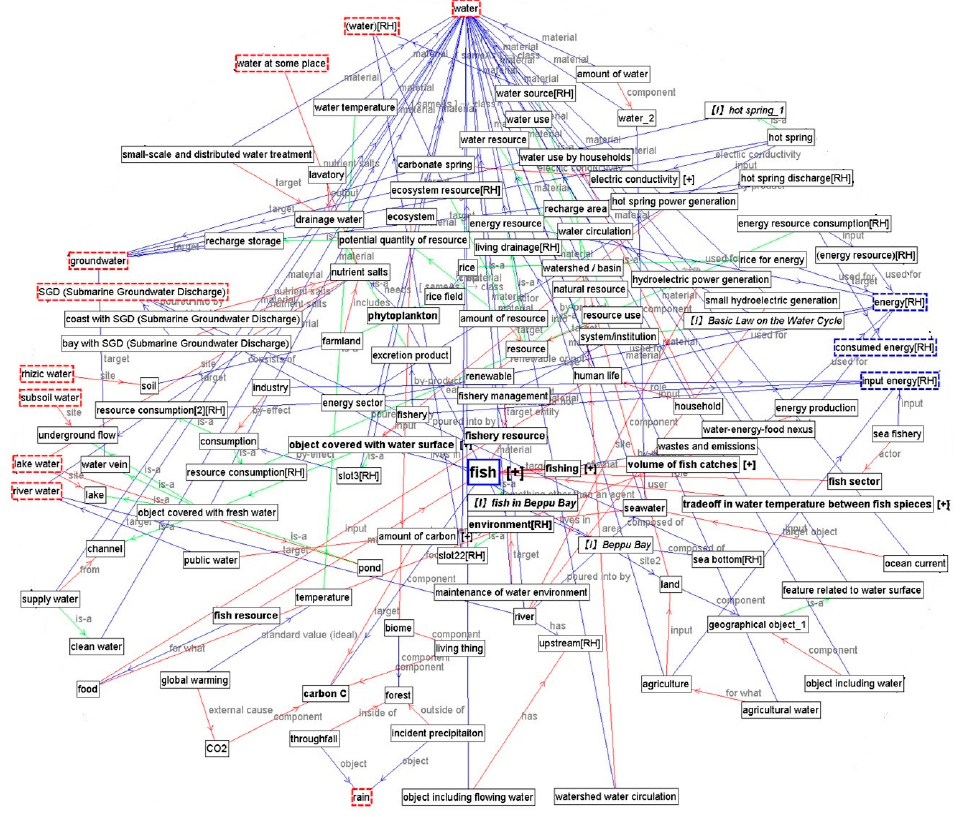
Figure 10. The “fish”–water–energy nexus system map.